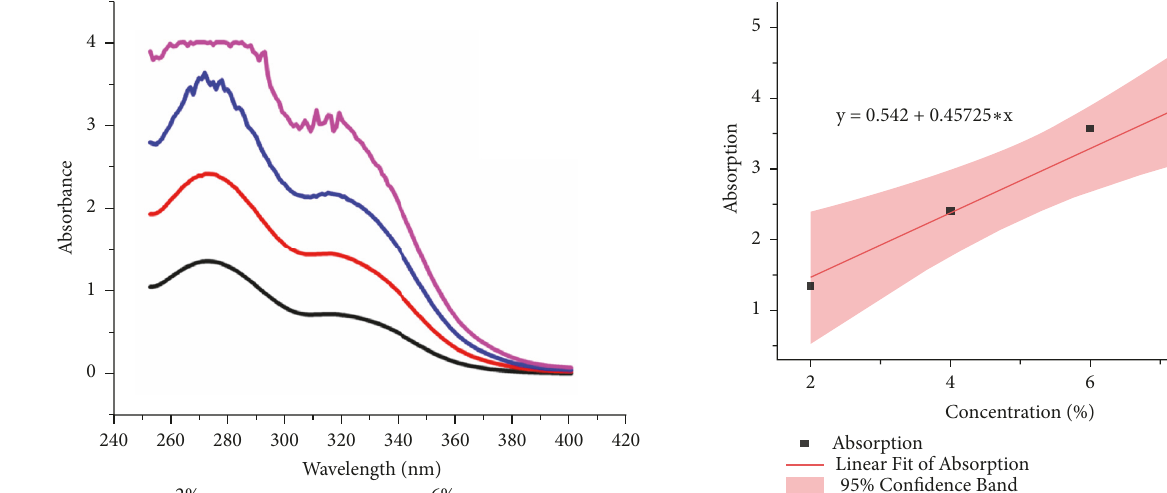
Figure 10: Standard curve of streptomycin with several concentra- tions.